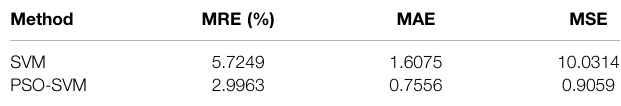
TABLE 3 | Comparison of two method for battery #1.